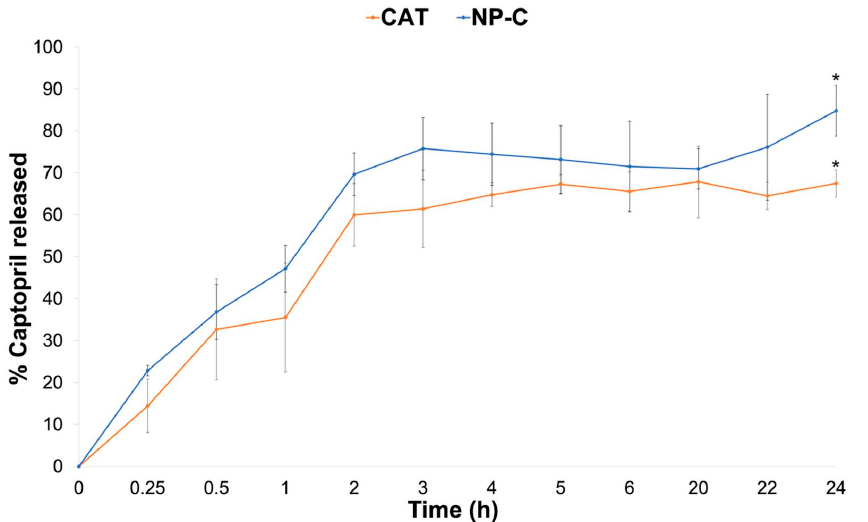
Figure 7. Comparison of the in vitro drug release profiles from the NP ‐ C and CAT solutions. * p value < 0.05: CAT vs. NP ‐ C after 24 h.